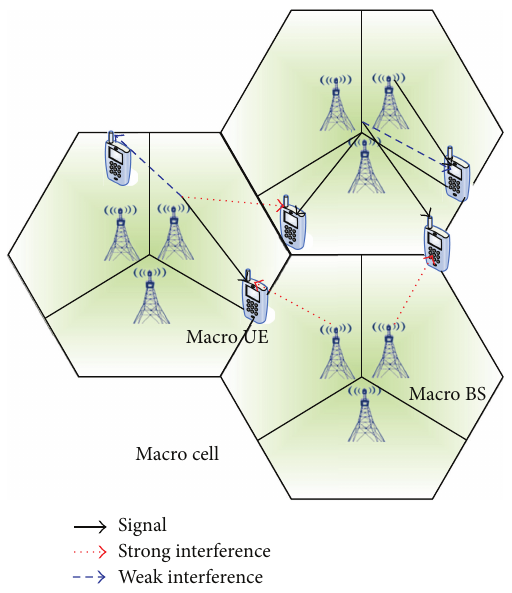
Figure 1: System model for downlink transmission of LTE- Advanced networks.